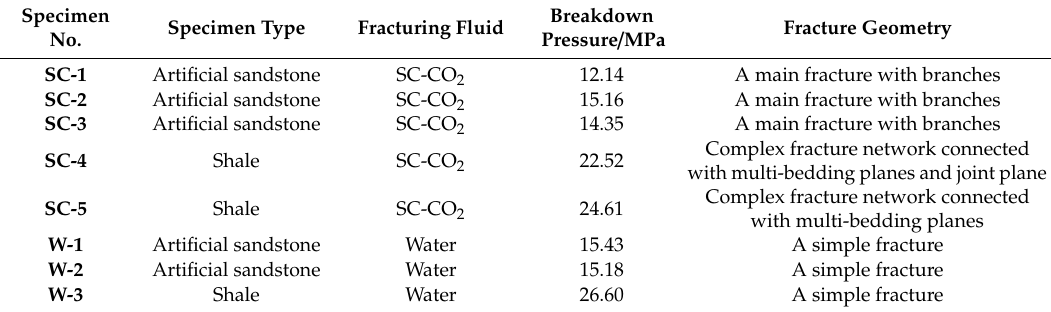
Table 2. Experimental parameters and results.